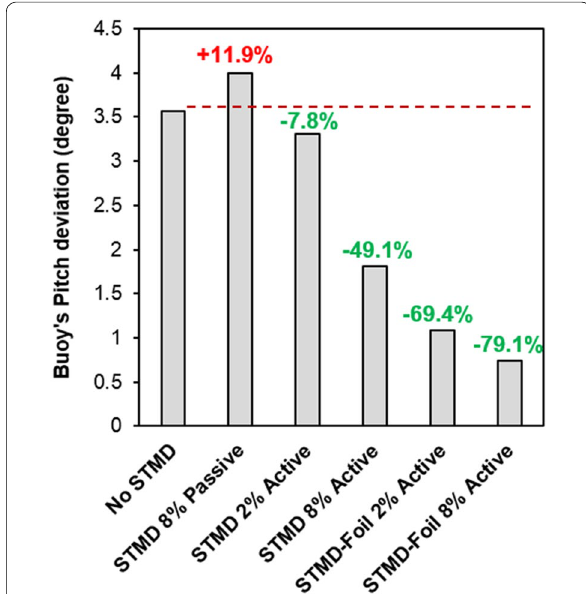
Fig. 18 Response of the buoy with different control strategies A standard deviation of the buoy’s pitch deviation with proposed control strategies in response to a series of continuous waves with different heights and periods is